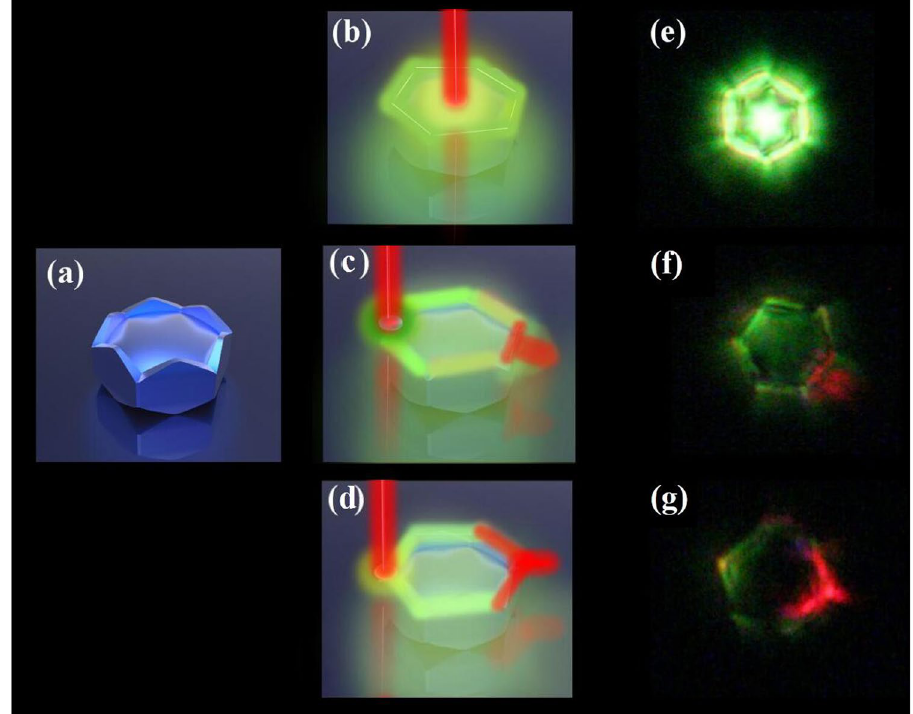
Figure 2. ( a ) Schematic illustration of the microcrystal structure. ( b ) to ( d ) Schematic illustration of PS β HM under specific location of the excitation light. ( e ) to ( g ) Typical UC luminescence emission observed with corresponding location of the excitation